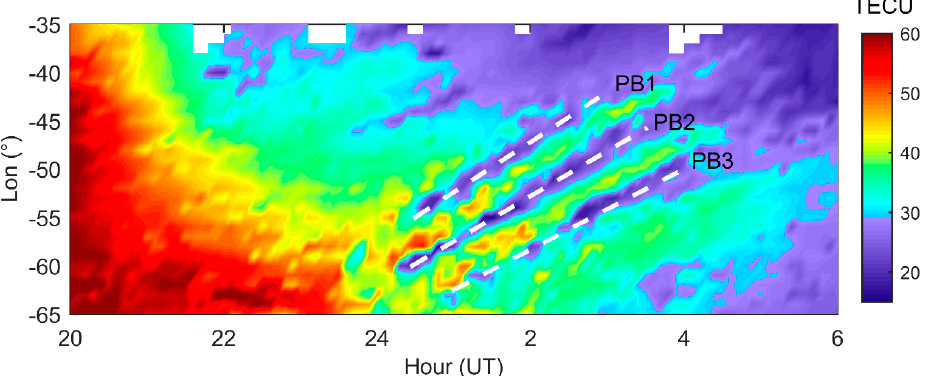
Figure 5. Keogram of the VTEC values at the latitudinal section of 25°S in terms of longitude and hours at the night of DOYs 358 and 359 from 2013.